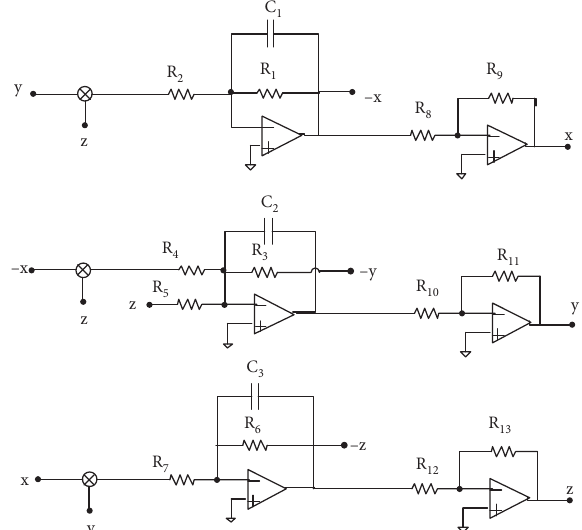
Figure 7: Circuit diagram of system (3a)–(3c) describing SynRM without external